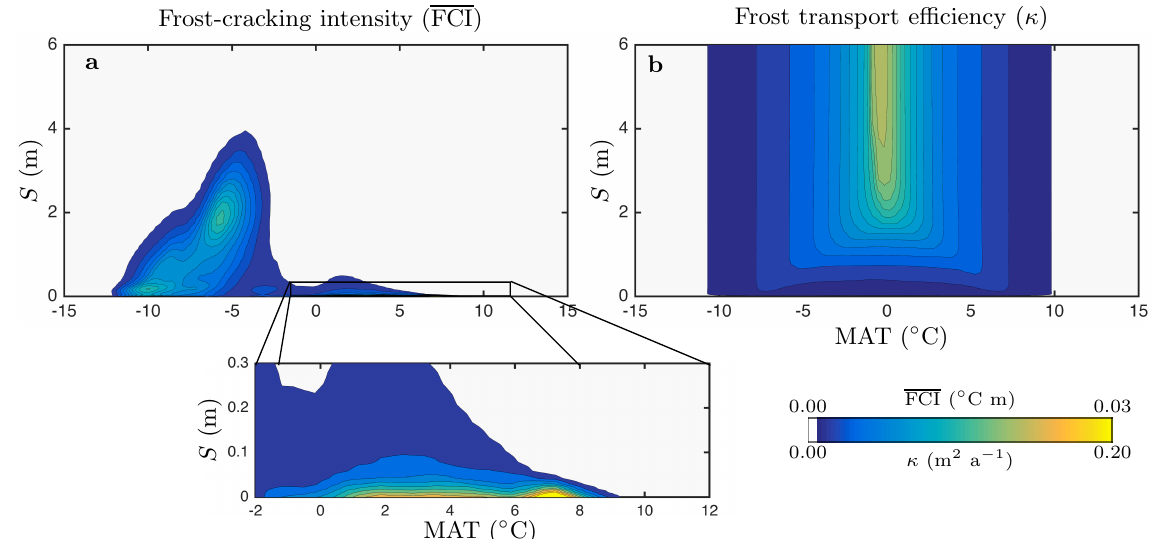
Figure 3. Frost-cracking intensity (FCI) (a) and frost-driven sediment transport efficiency ( κ ) (b) contours shown as functions of mean annual temperature (MAT) and sediment cover thickness ( S ). The contour plots are created from modelled values of frost cracking and frost creep for a range of combinations of MAT and S . These results were obtained by solving the one-dimensional heat equation and integrating the rates through annual temperature cycles. The model is documented in detail in the accompanying paper (Andersen et al.,